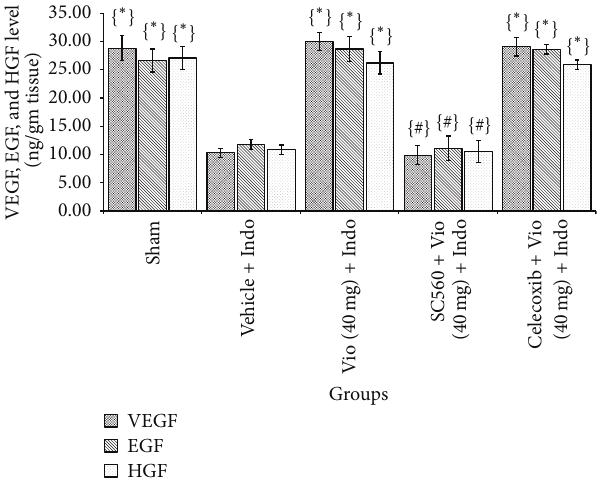
Figure 7: Effect of COX-1 and COX-2 inhibitors and violacein (40 mg/kg, orally) on VEGF, EGF, and HGF levels in indomethacin- induced ulcerated rats. Values are mean ± SD ( n = 6). ∗ 𝑃 < 0.05 compare vehicle + Indo with all the groups; # 𝑃 < 0.05 compare Vio (40mg)+IndowithSC560orCelecoxib+Vio(40 mg)+Indo.Indo: indomethacin; Vio: violacein.